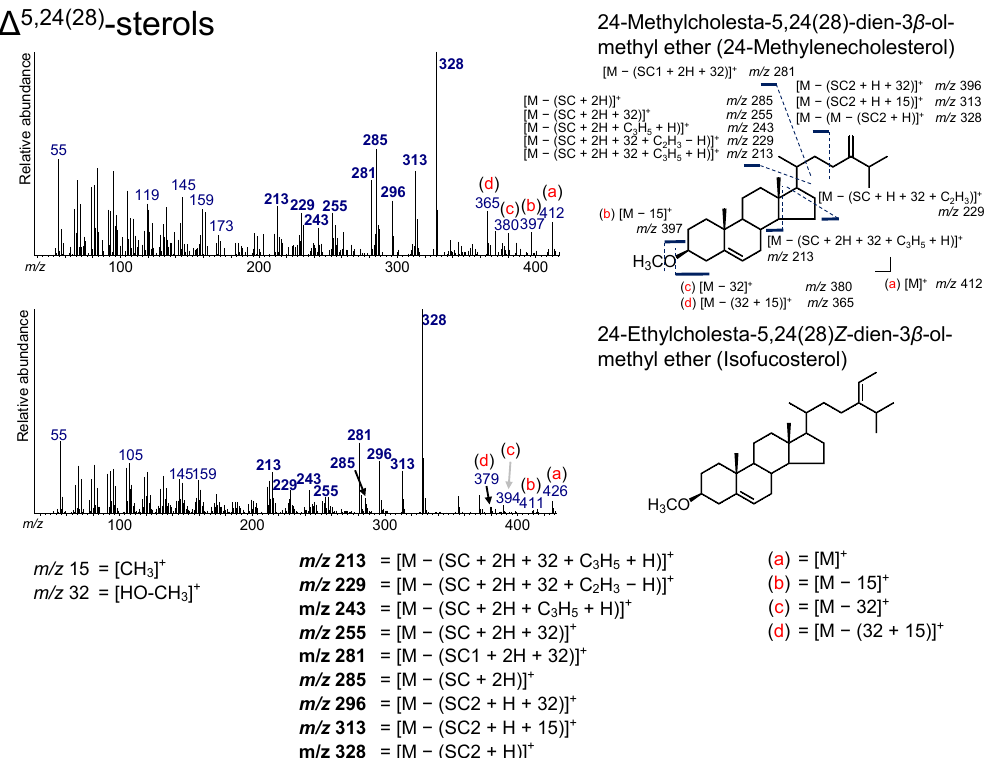
Figure 10. Electron ionization mass spectrum of ∆ 5,24(28) -sterol. Bold numbers indicate an ion that accompanies the cleavage of the side chain. ( a )–( d ) Ions that are not accompanied by the loss of the side chain.